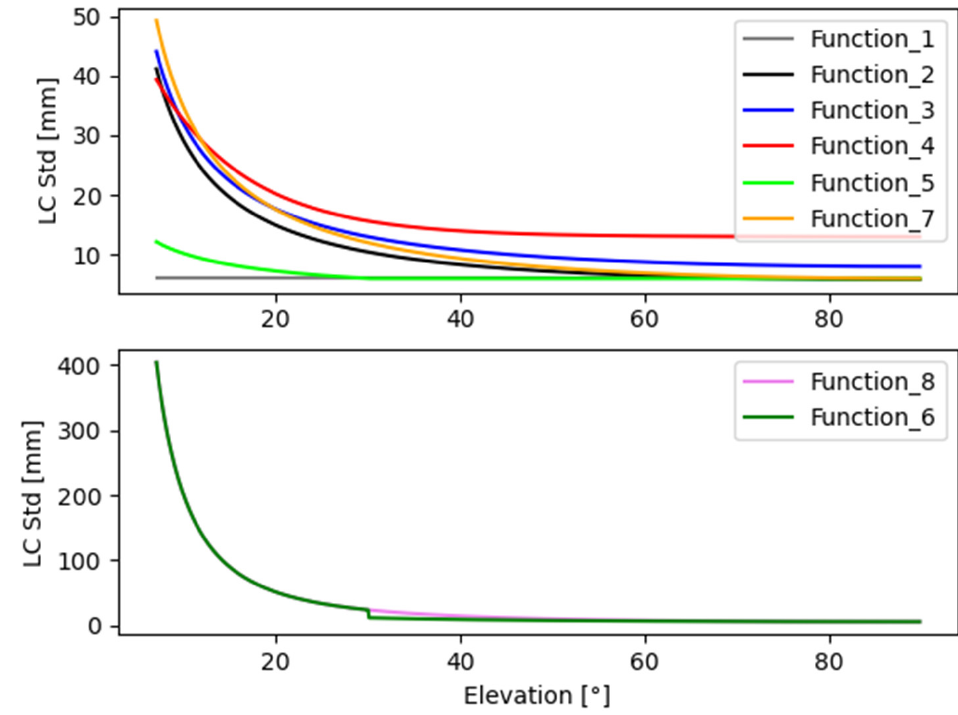
Figure 12. Standard deviations of carrier-phase of ionosphere-free linear combination with elevation angle for analyzed weighting functions. Bottom plot for Function_6 and Function_8. Top plot for the rest of the functions.